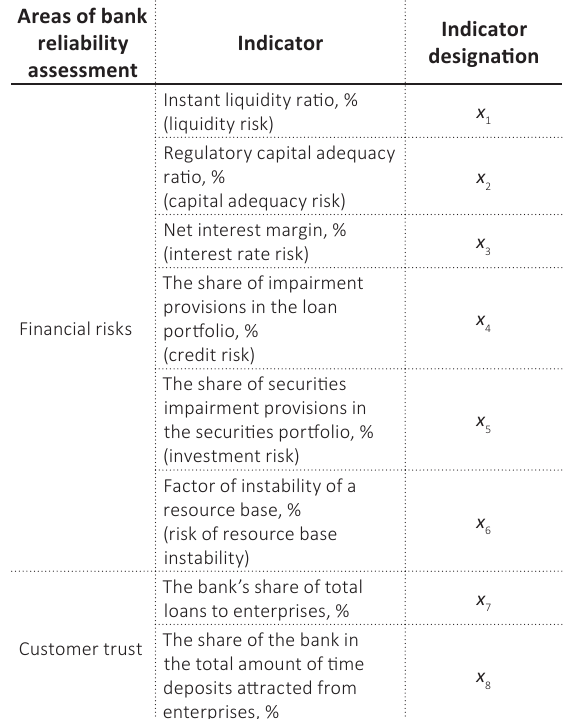
Table 1. Financial parameters for determining bank